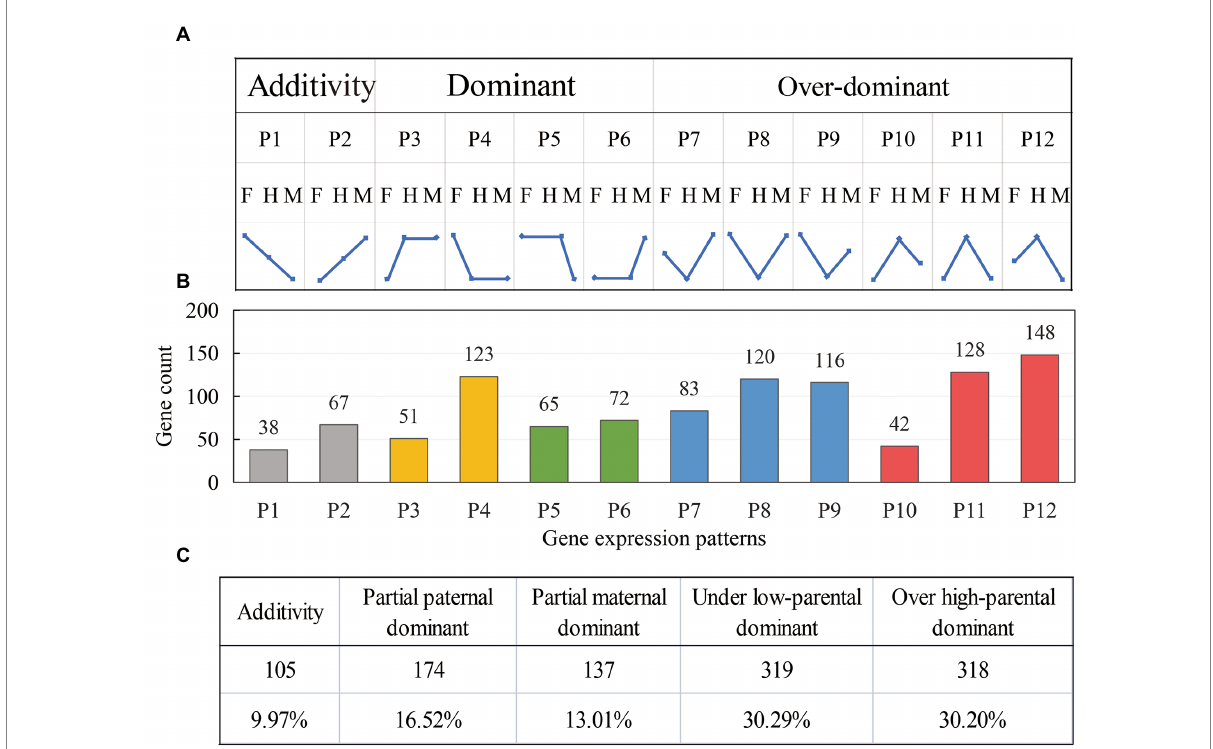
FIGURE 4 Identification and classification of differential gene expression patterns in the hybrids. (A) The division of 12 expression patterns; F: female parent, H: hybrid, and M: negative parent. (B) The distribution of DEGs in the hybrids among 12 expression patterns. (C) The number and proportion of DEGs in the five expression patterns.